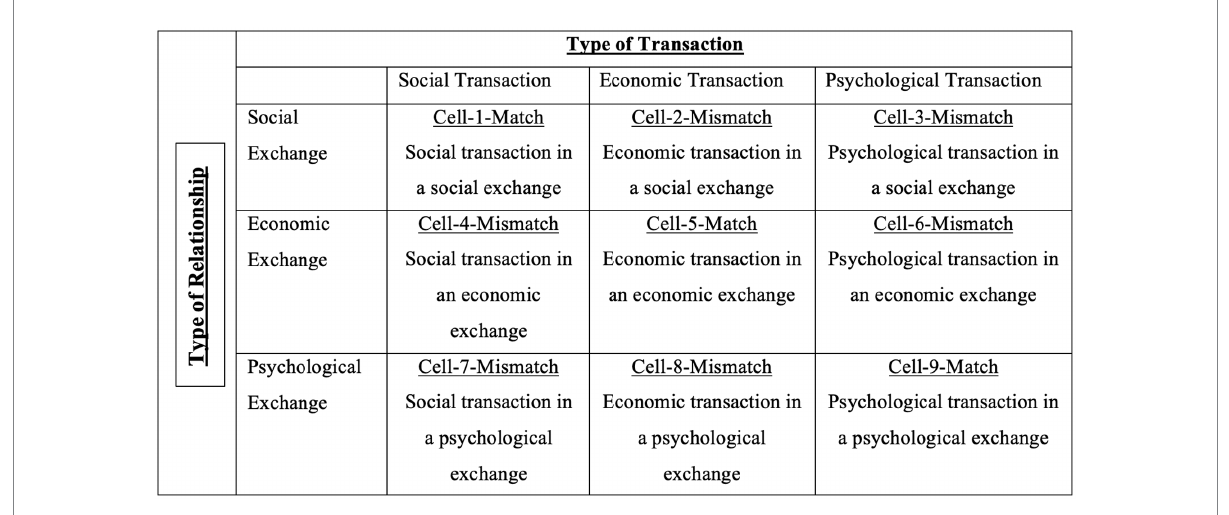
FIGURE 2 Proposed model of transactions and